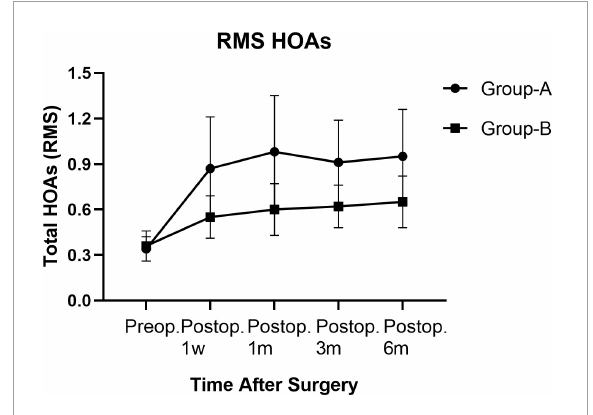
FIGURE3 Root mean square HOAs of groups A and B from preoperative baseline to the 6 months after surgery.